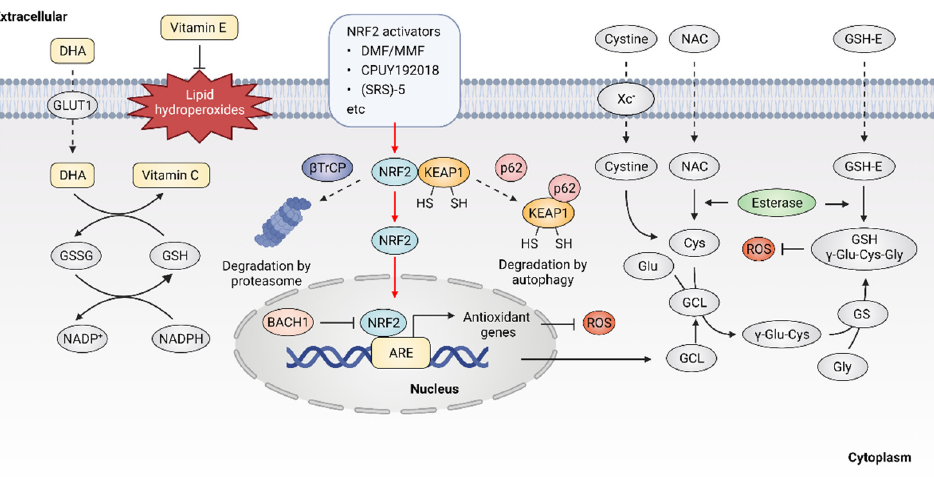
Figure 3. Targeting ROS with nonenzymatic antioxidants. Dehydroascorbic acid (DHA), the oxidized form of vitamin C, is taken up by cells through glucose transporter 1 (GLUT1) and then reduced to vitamin C. Vitamin E is located in cell membranes and defends against lipid hydroperoxides. NRF2 activators may disrupt the KEAP1-NRF2 interaction, leading to the activation of NRF2 downstream antioxidant genes. Glutathione (GSH) is synthesized from cysteine, glutamate and glycine. Exogenous N-Acetyl cysteine (NAC) and GSH esters (GSH-E) supplementation promote GSH production and defense against excessive ROS.